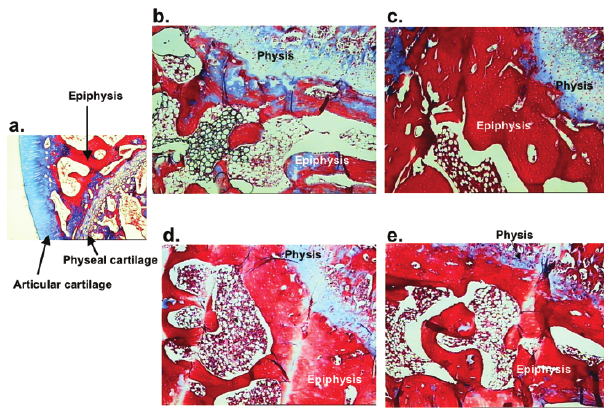
Figure 2 - Photomicrographs of 5 mm decalcified sections of the operated (left hip, B, C) and non-operated (right hip, D, E) proximal femoral epiphyses-physes of an adult rabbit (same as shown in Figures 1 and 3) obtained 6 weeks following a left intertrochanteric femoral osteotomy and internal fixation, stained with Masson’s trichrome method (magnification, 40x (B, D) and 100x (C, E). Caption A illustrates the anatomic location of the histologic sections with the physeal cartilage as the anatomic boundary. Please note the extensive area of bone marrow vessels in the operated proximal epiphysis (arrows, C) as compared with the corresponding region on the contrateral hip (arrows,